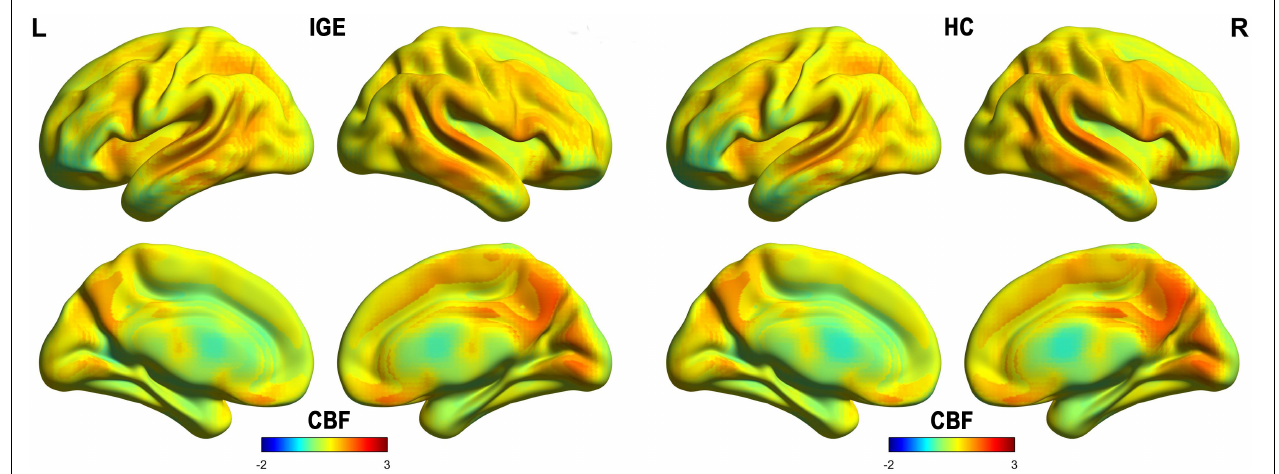
FIGURE 1 | Spatial distribution maps of CBF at the group level. For each group (i.e., IGE or HC), the individual CBF maps were normalized to z-scores and then averaged across subjects to generate a group-level map. IGE, idiopathic generalized epilepsy; CBF, cerebral blood flow; HC, healthy controls.